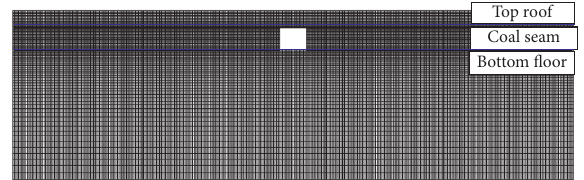
Figure 3: Numerical model of stress of thin immediate roof under uniform load.